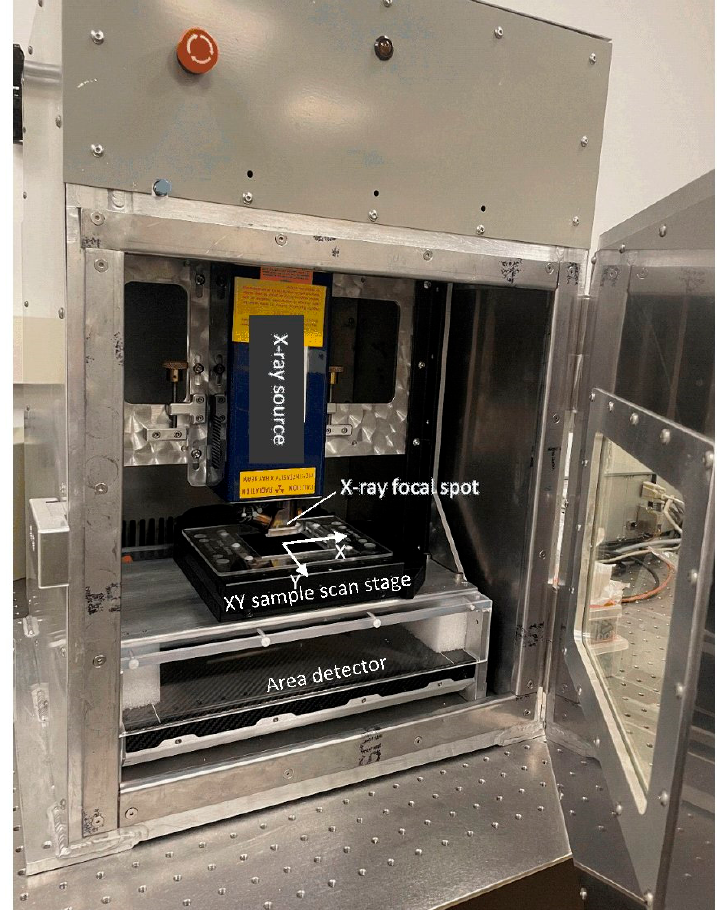
Figure 1. The X-ray micro tomosynthesis scanner with the radiation enclosure. The outer dimensions of the enclosure are 45 × 52 × 66 cm (width × depth × height). The motorized sample stage moves nominally in the horizontal plane. The sample is scanned horizontally across the vertical cone beam in either x or y direction. Flat samples are usually scanned in a horizontal plane near the X-ray focal spot to maximize the photon flux density through the sample and the geometric magnification for greater contrast-to-noise ration and resolution.